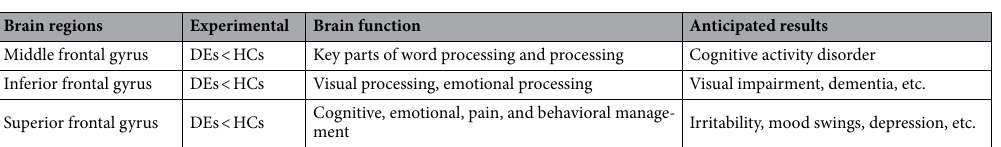
Table 5. Brain regions alternation and its potential impact. DE dry eye, HC healthy